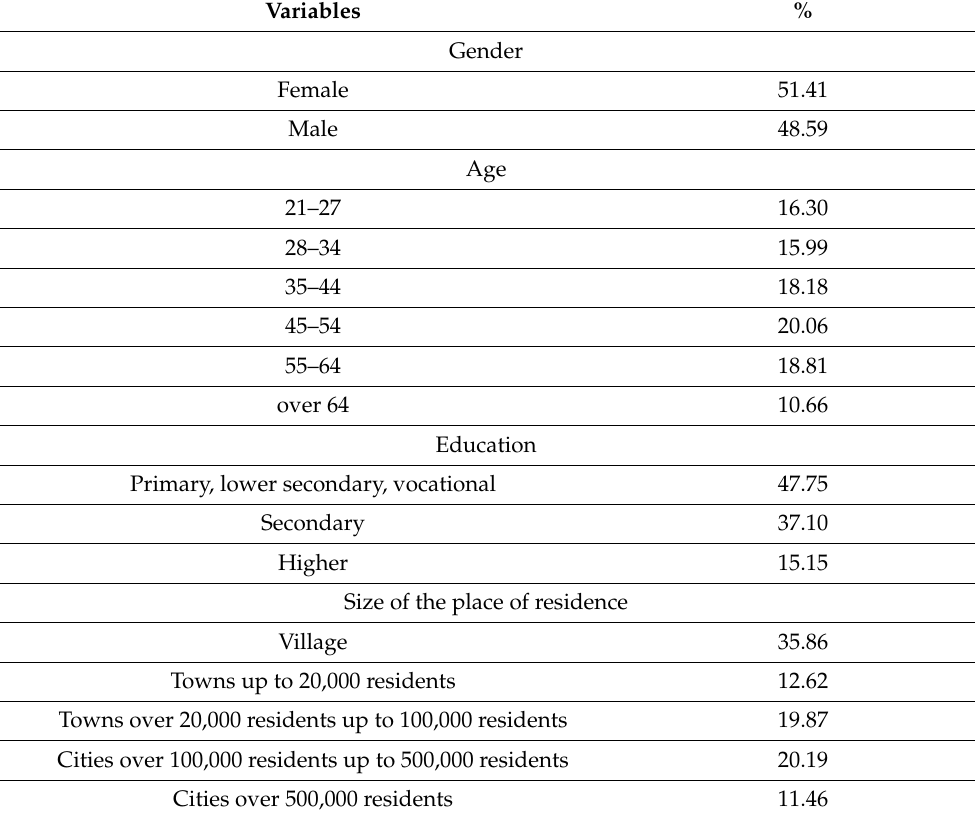
Table 2. Socio-demographic characteristics of the consumers surveyed ( N = 983, Poland) (%).